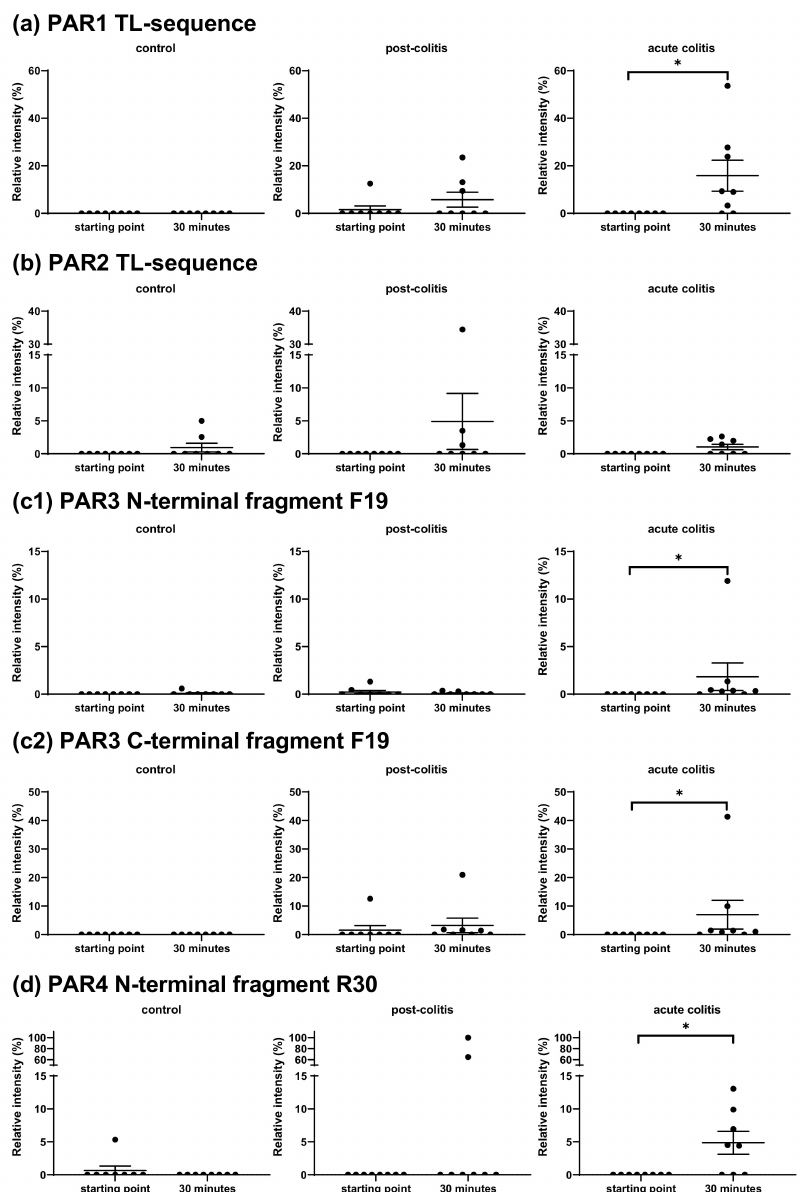
Figure 7. Relative intensities of ( a ) the fragment representing the TL-sequence of PAR1 after incu- bation of a PAR1-based peptide with colonic samples from control, post-colitis and acute colitis rats. There is a significant increase of this fragment in acute colitis samples after 30 min of incuba- tion; ( b ) the fragment representing the TL-sequence of PAR2 after 10 and 30 min of incubation of a PAR2-based peptide with colonic samples from control, post-colitis and acute colitis rats. There is no significant difference in the abundance of this fragment between the groups ( c1 ) N-terminal and ( c2 ) C-terminal fragment after the disarming cleavage of the PAR3-based peptide at phenylalanine on position 19 at the starting point and after 30 min of incubation with colonic samples from control, post-colitis and acute colitis rats. The increase of both fragments is significant after incubation with acute colitis samples; ( d ) the N-terminal fragment after cleavage of the PAR4-based peptide after arginine in position 30 after incubation with samples from control, post-colitis and acute colitis rats. This fragment is significantly increased after incubation with acute colitis samples. The C-terminal fragment of this cleavage is not detected. Statistics: Wilcoxon signed-rank test. The mean and SEM are shown. n = 8 animals per group * p <